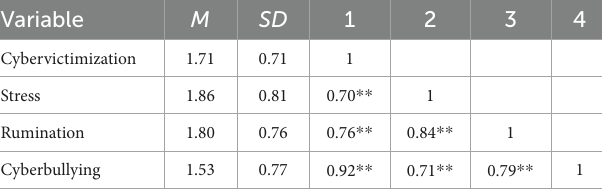
TABLE 1 Means, standard deviations, and correlations between cybervictimization, stress, rumination, and cyberbullying. Variable